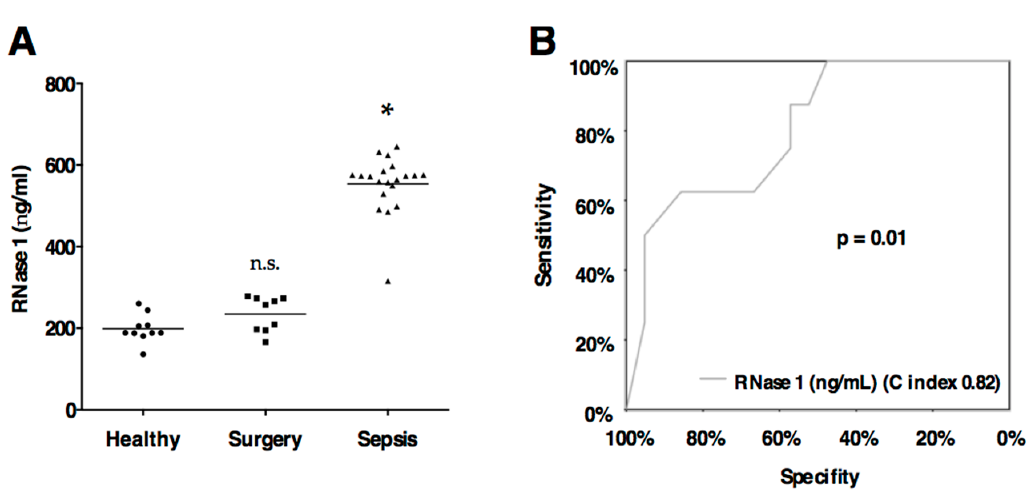
Figure 1. ( A ) RNase 1 serum levels. Serum levels of ribonuclease 1 (RNase 1) are displayed according to the groups. Black line indicates the mean. Groups: Healthy subjects ( n = 10), surgical ICU patients (Surgery, n = 9) and surgical ICU patients with sepsis ( n = 20) according to the definition published by the Surviving Sepsis Campaign [40]. * p < 0.05 vs. Healthy; n.s., non significant vs. Healthy; ( B ) RNase